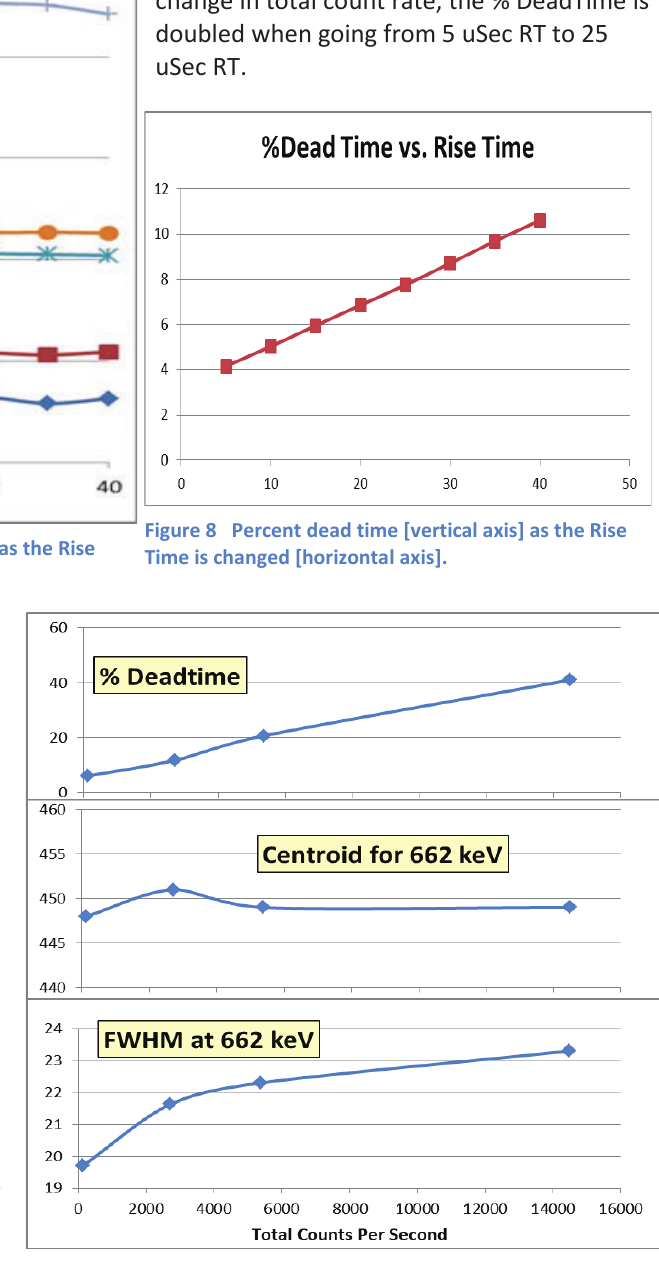
Figure 7 FWHM for 5 energies from 60 to 2614 keV as the Rise Time is varied.